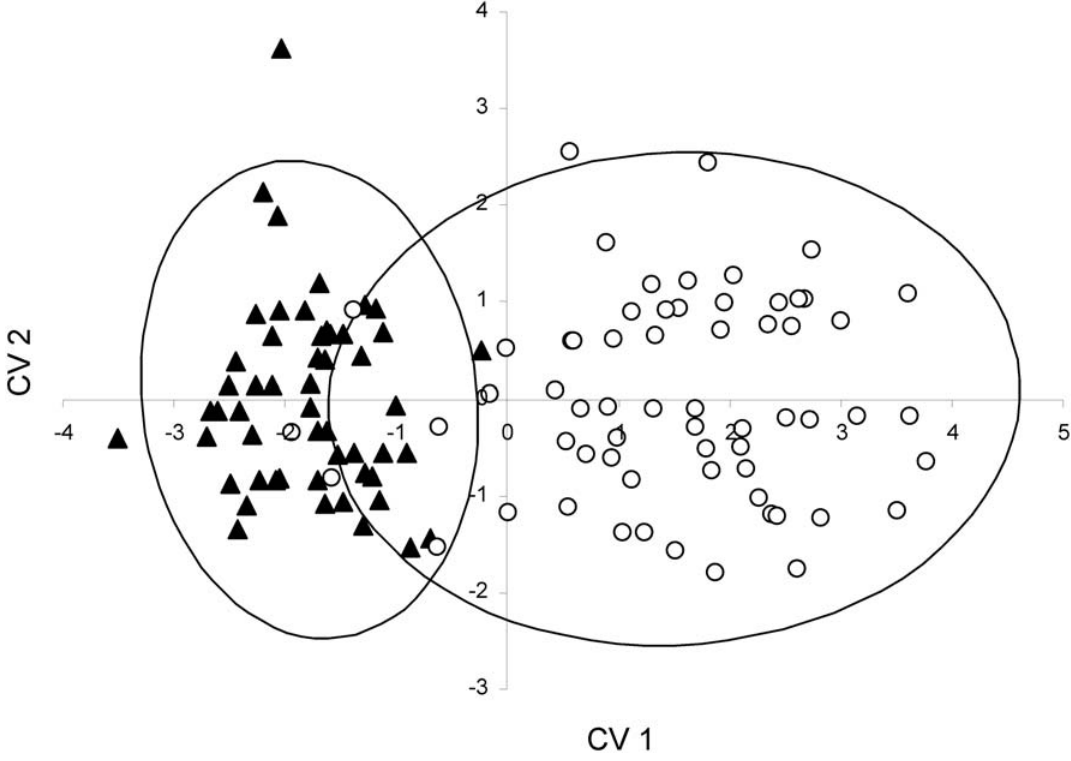
Figure 4. Plot of canonical variates 1 and 2 from the discriminant function analysis showing the position of each male from the two genetic lineages (N=116). Filled triangles represent the western lineage and unfilled circles represent the eastern lineage. Ellipses represent 95% confidence ellipses. CV1 differentiates individuals based primarily on tick load, spectral purity of the side and body condition (standardised canonical correlation between CV1 and tick load=0.95; side spectral purity= 2 0.46; body condition= 2 0.36). CV 2 discriminates between populations primarily on ventral brightness (standardised correlation=0.95).